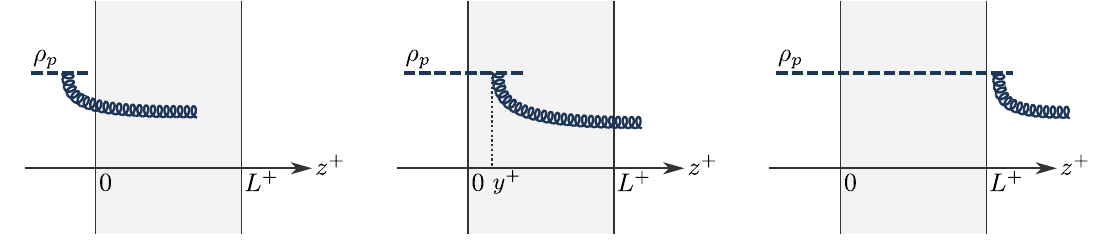
Fig. 1 Diagrammatic representation of the three terms appearing in Eq. (2.2) where the gluon is emitted before, inside or after the